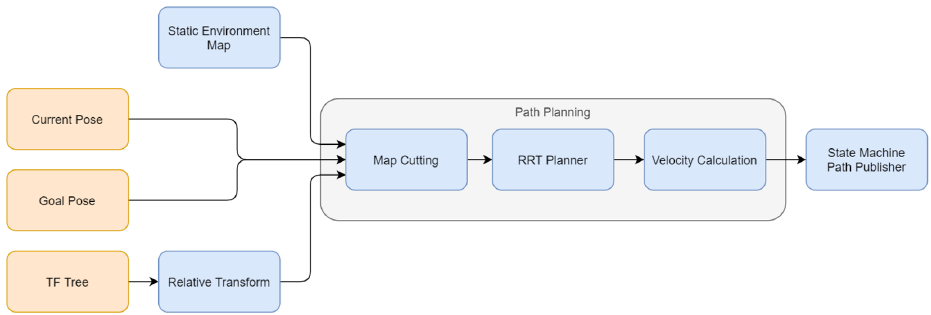
Figure 11. Architecture of the path planning for parking pipeline of the PVLSA